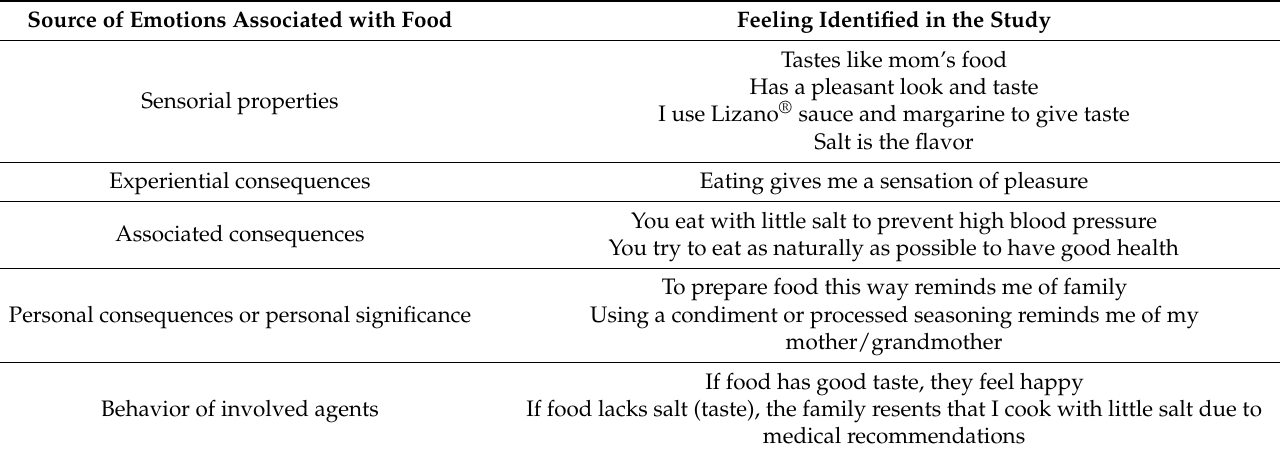
Table 1. The five sources of emotions associated with the consumption of homemade food with salt/sodium. Source of Emotions Associated with Food Feeling Identified in the Study